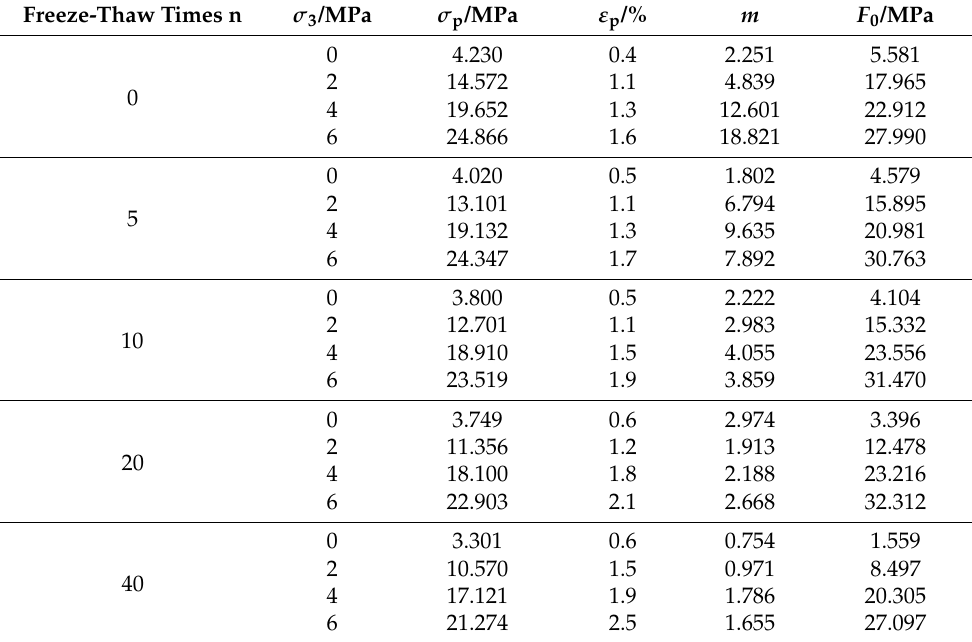
Table 6. Model calculation parameters of red sandstone under different freeze-thaw cycles and confining pressures.